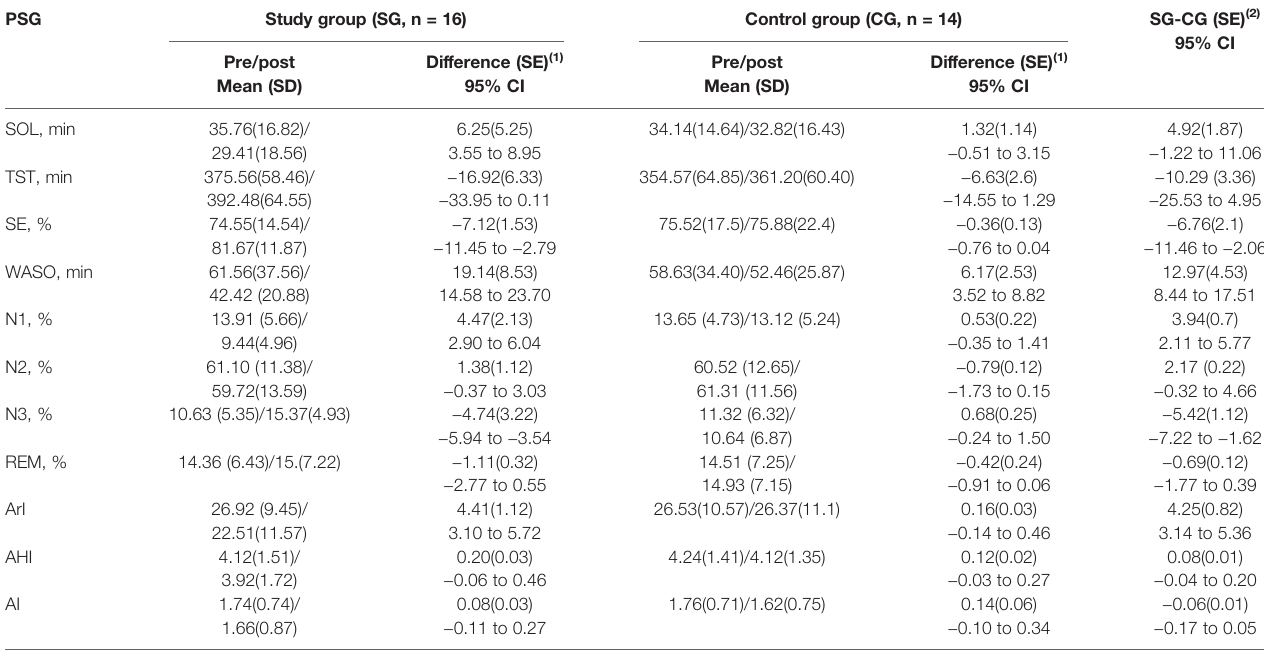
TABLE 3 | Comparisons of sleep quality between the two